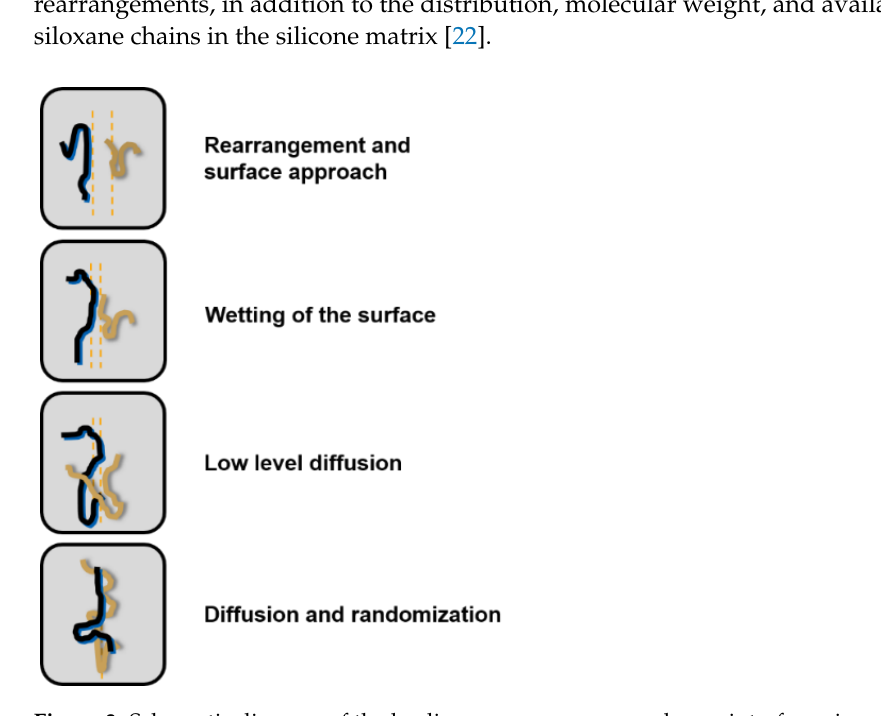
Figure 3. Schematic diagram of the healing process across a polymer interface via molecular inter- diffusion [23]. Reprinted with permission from Ref [23]. Copyright 2008 Elsevier.